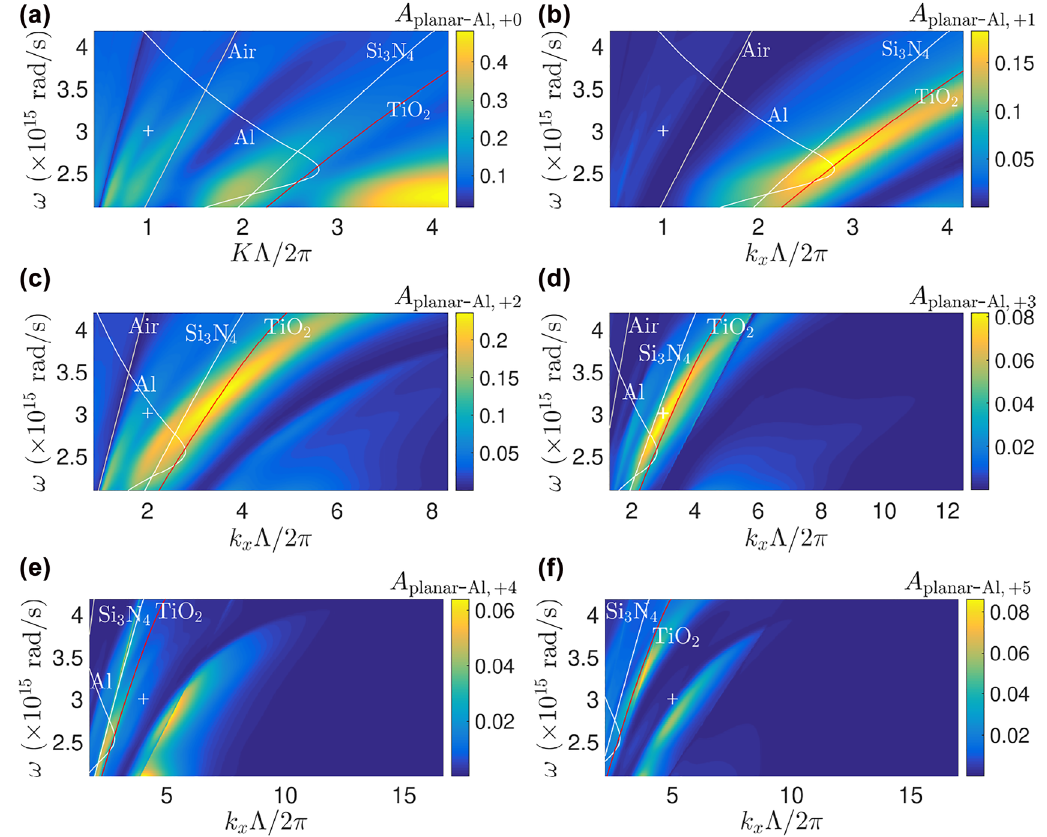
as a function of angular frequency and planar − Al N , and TiO 3 4 2 = 627 nm is marked by a cross symbol in each 0